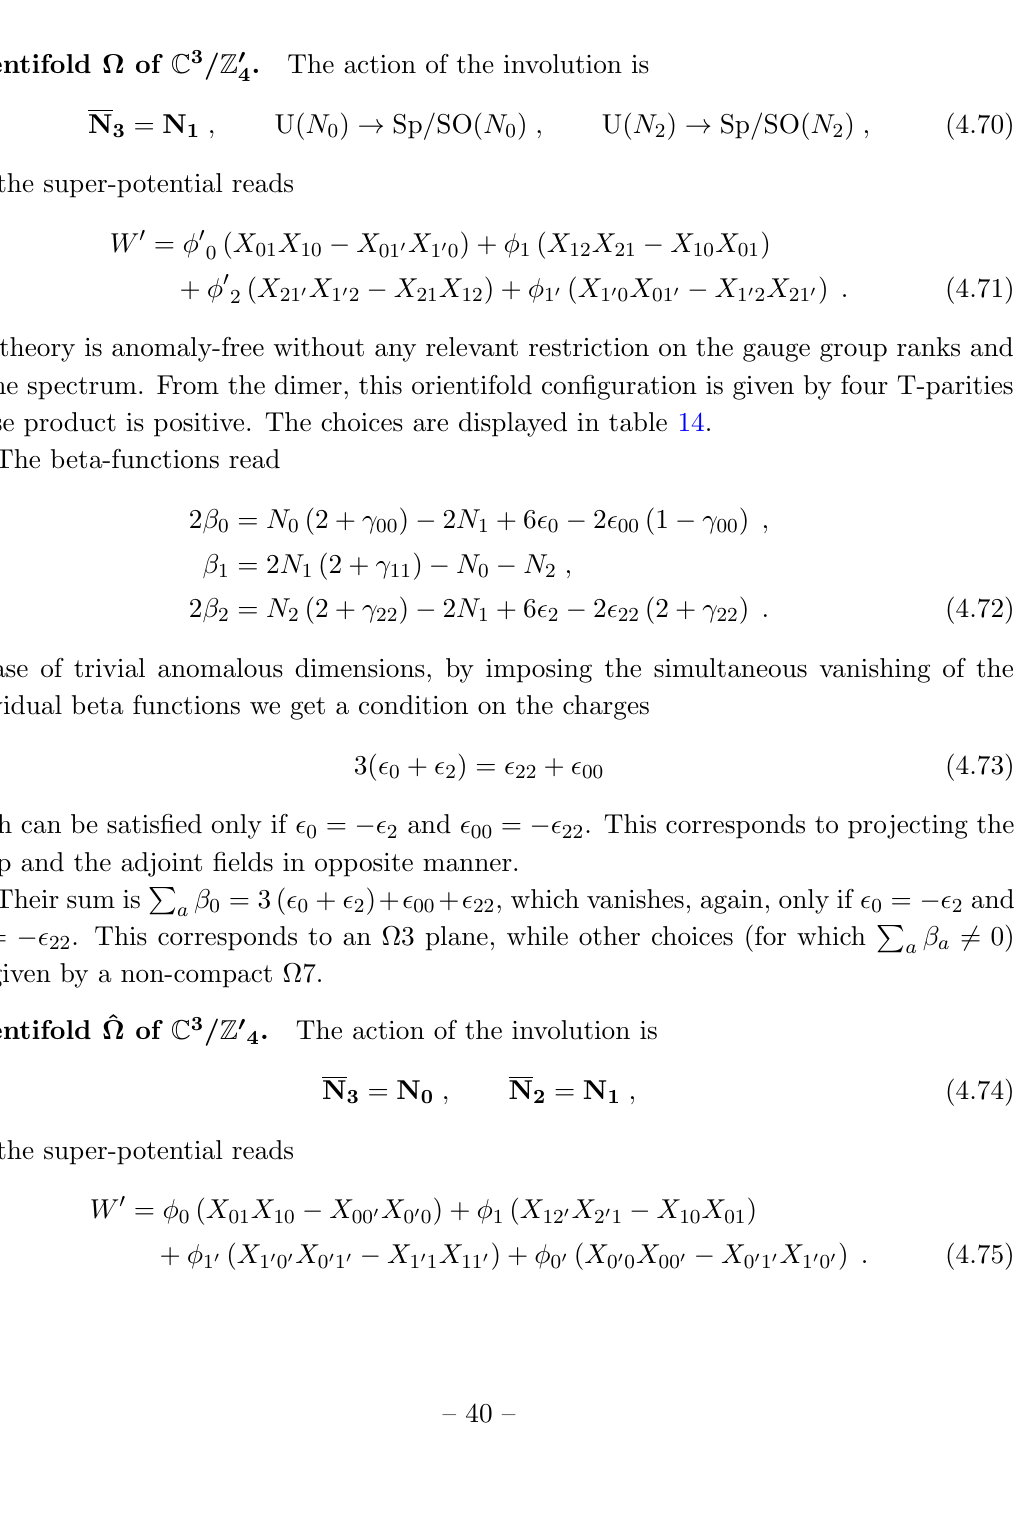
Table 14. The orientifold projection (cid:10) of C 3 = Z 0 4 . \A" stands for \Antisymmetric representation", while \S" for \Symmetric